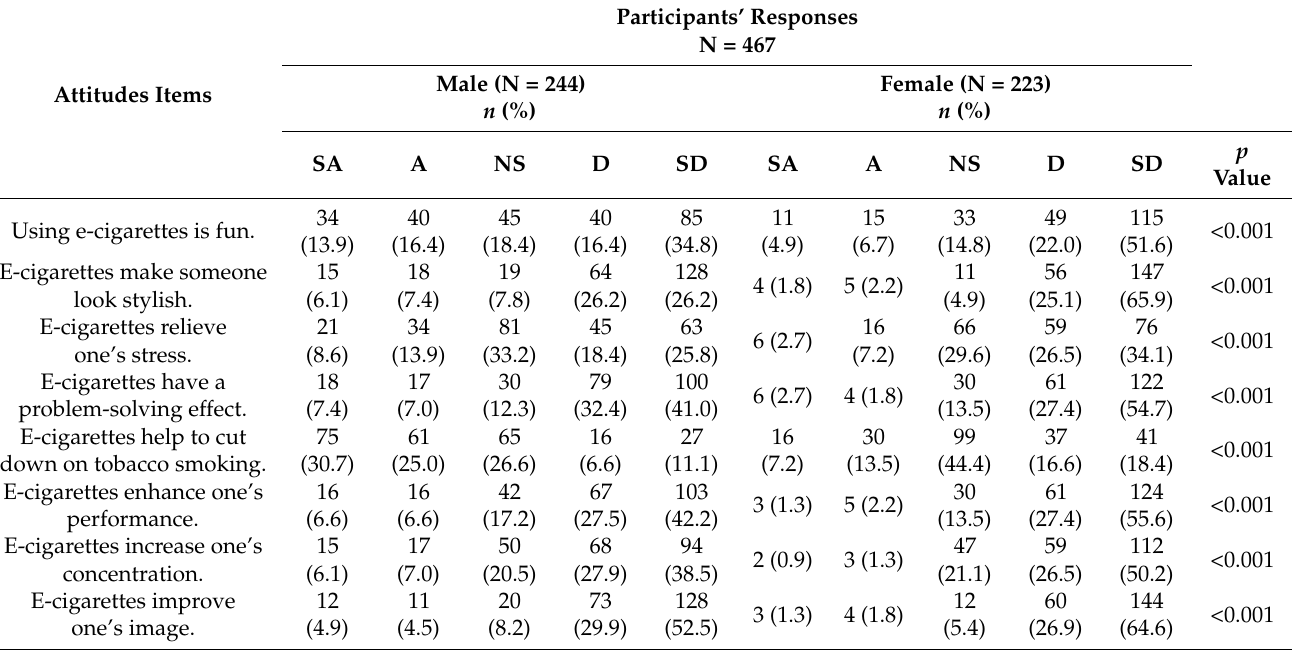
Table 5. Attitude towards e-cigarettes among first-year university students, stratified by